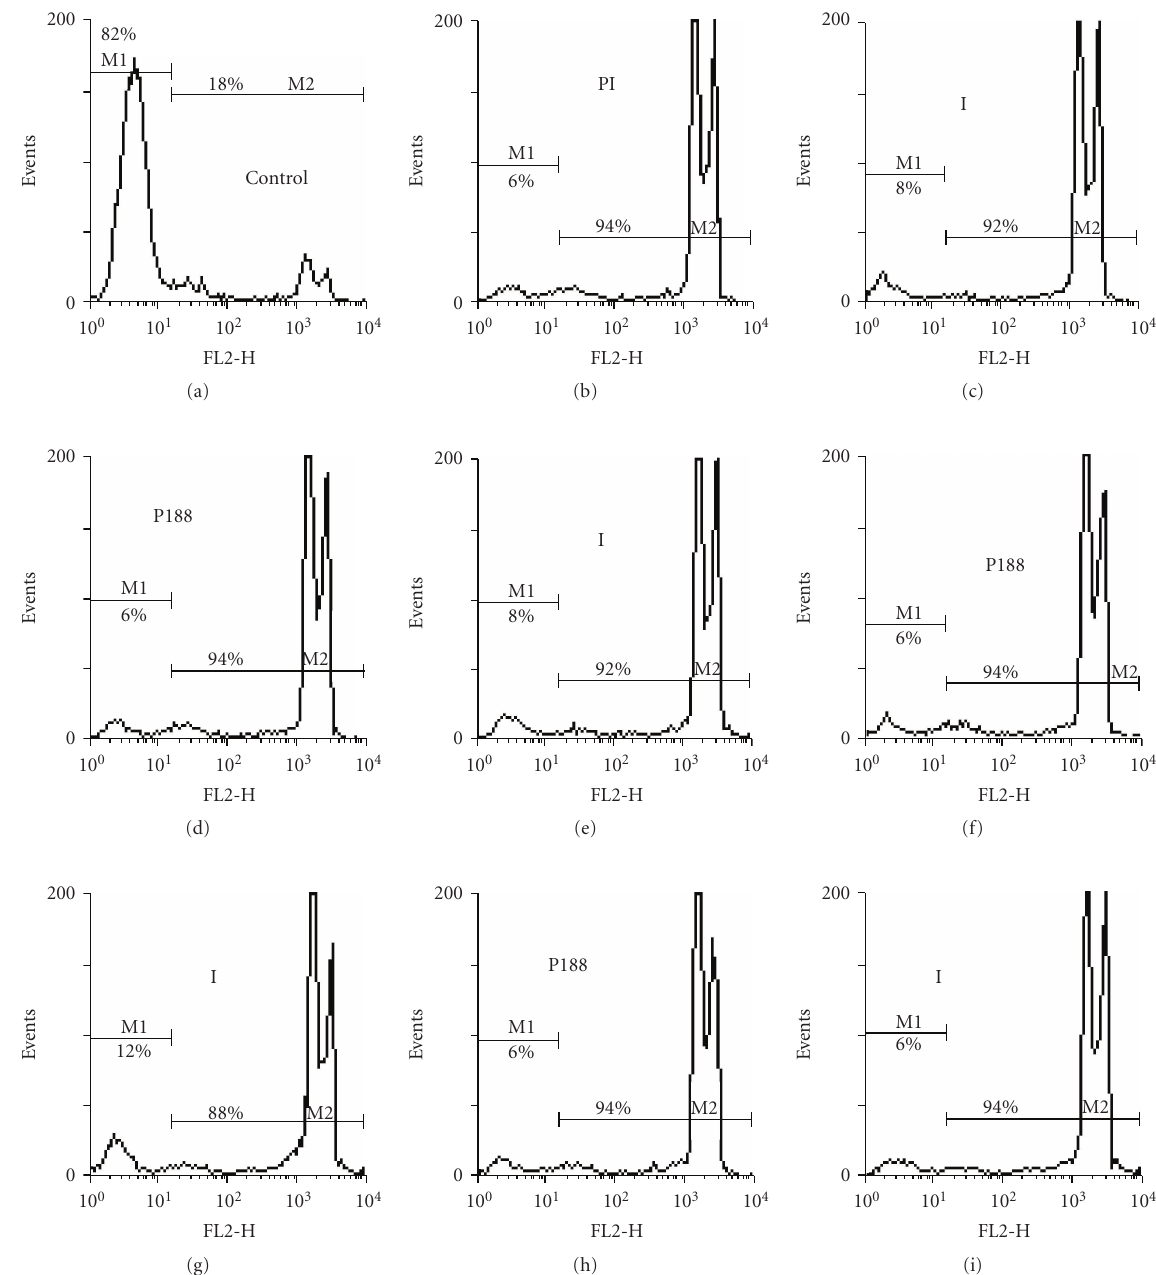
Figure 4: Flow cytometry of Jurkat cells. Other conditions are the same as in Figure